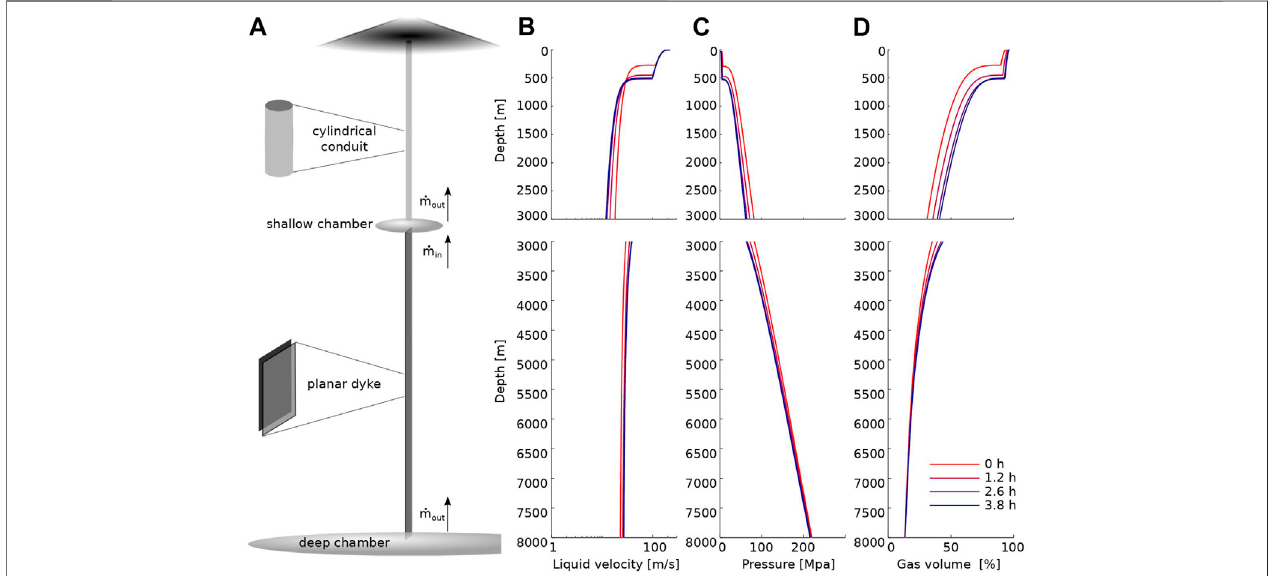
FIGURE 2 | Simulation setup. (A) Simulation domain. (B – D) Example calculations at different times.